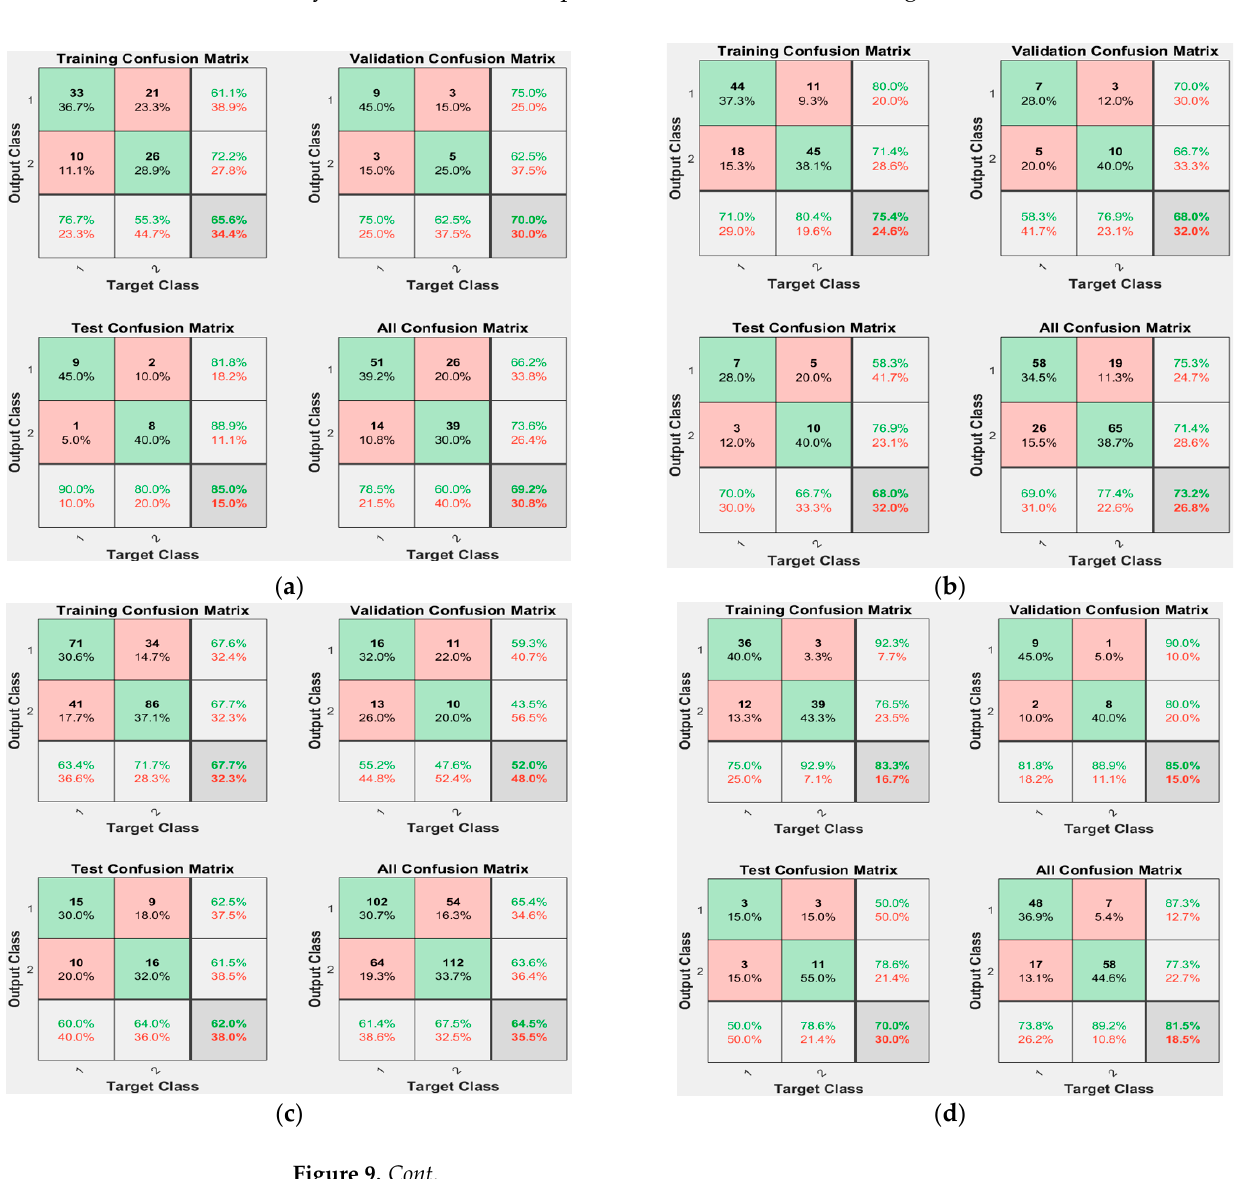
Table 5 lists the performance of Deep-IDH models using different hidden layers and data lengths. The model using the 2-layer hidden layer and 60 min data before the occurrence of IDH showed the maximum value after the performance metrics evaluation [ACC = 81.5 (%); TPR = 73.8 (%); PPV = 87.3 (%); and MCC = 0.638]. The MP-IDH model using one layer and 60 min data before IDH occurrence showed the maximum TPR value, and the longer the data length for the same number of hidden layers, the better the performance. In addition, the model using a data length of less than 60 min (30-min and 45-min data) before the occurrence of IDH showed higher ACC, PPV, and MCC values, as the number of hidden layers decreased. This suggests that reducing the number of hidden layers results in a better performance when the data length is less than 1